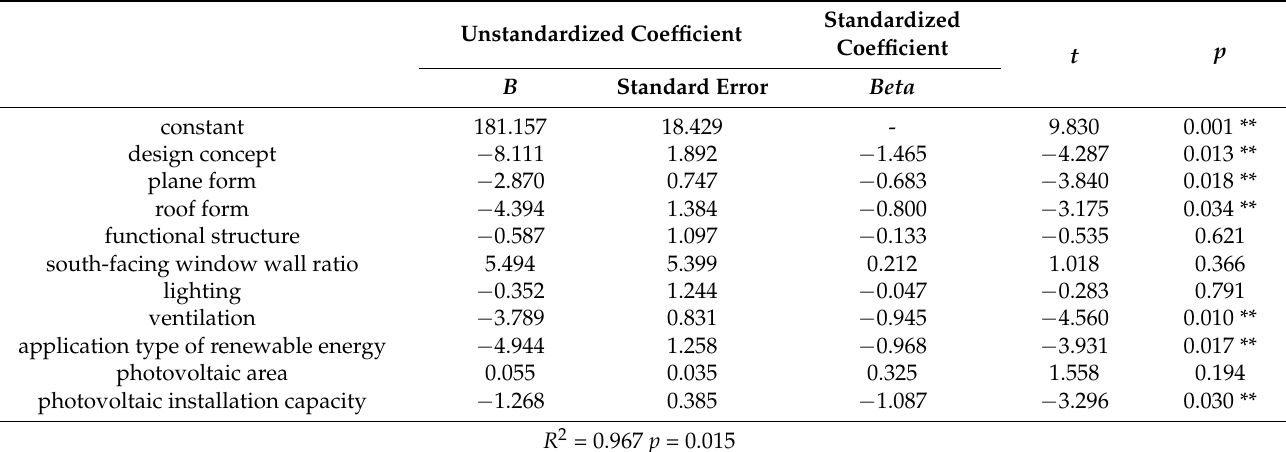
Table 12. Linear regression analysis with architecture contest scores as the dependent variable.